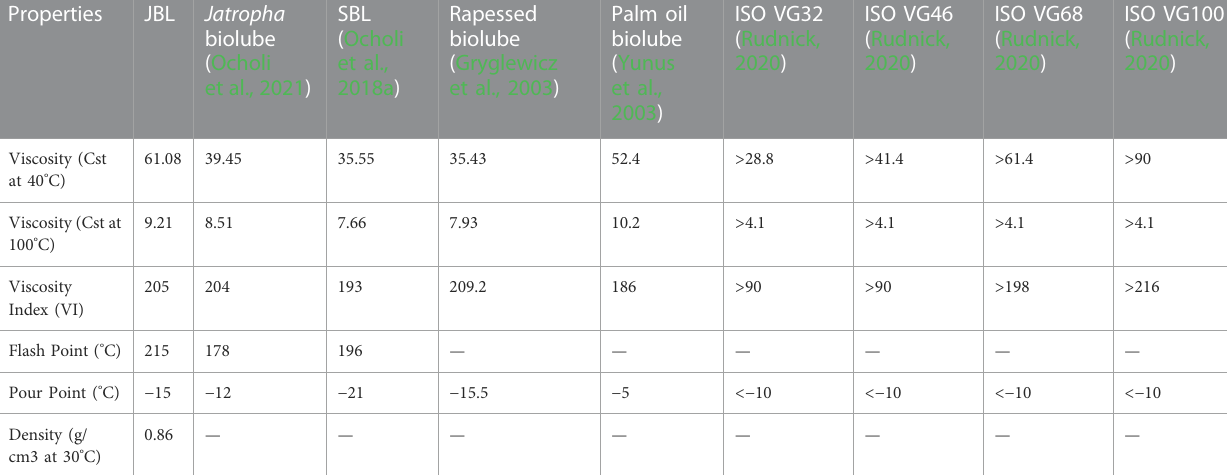
TABLE 4 Properties of jatropha biolubricant and comparison with other plant based biolubricants and ISO viscosity grades. Properties